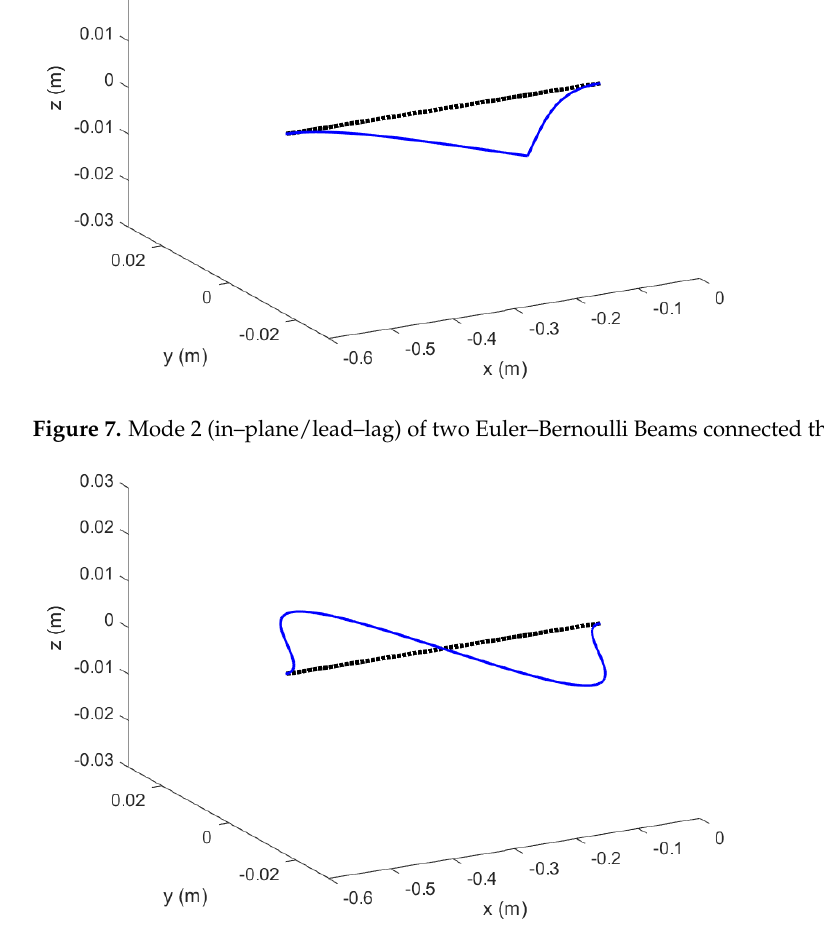
Figure 8. Mode 3 (out–of–plane/flapping) of two Euler–Bernoulli Beams connected through hinged